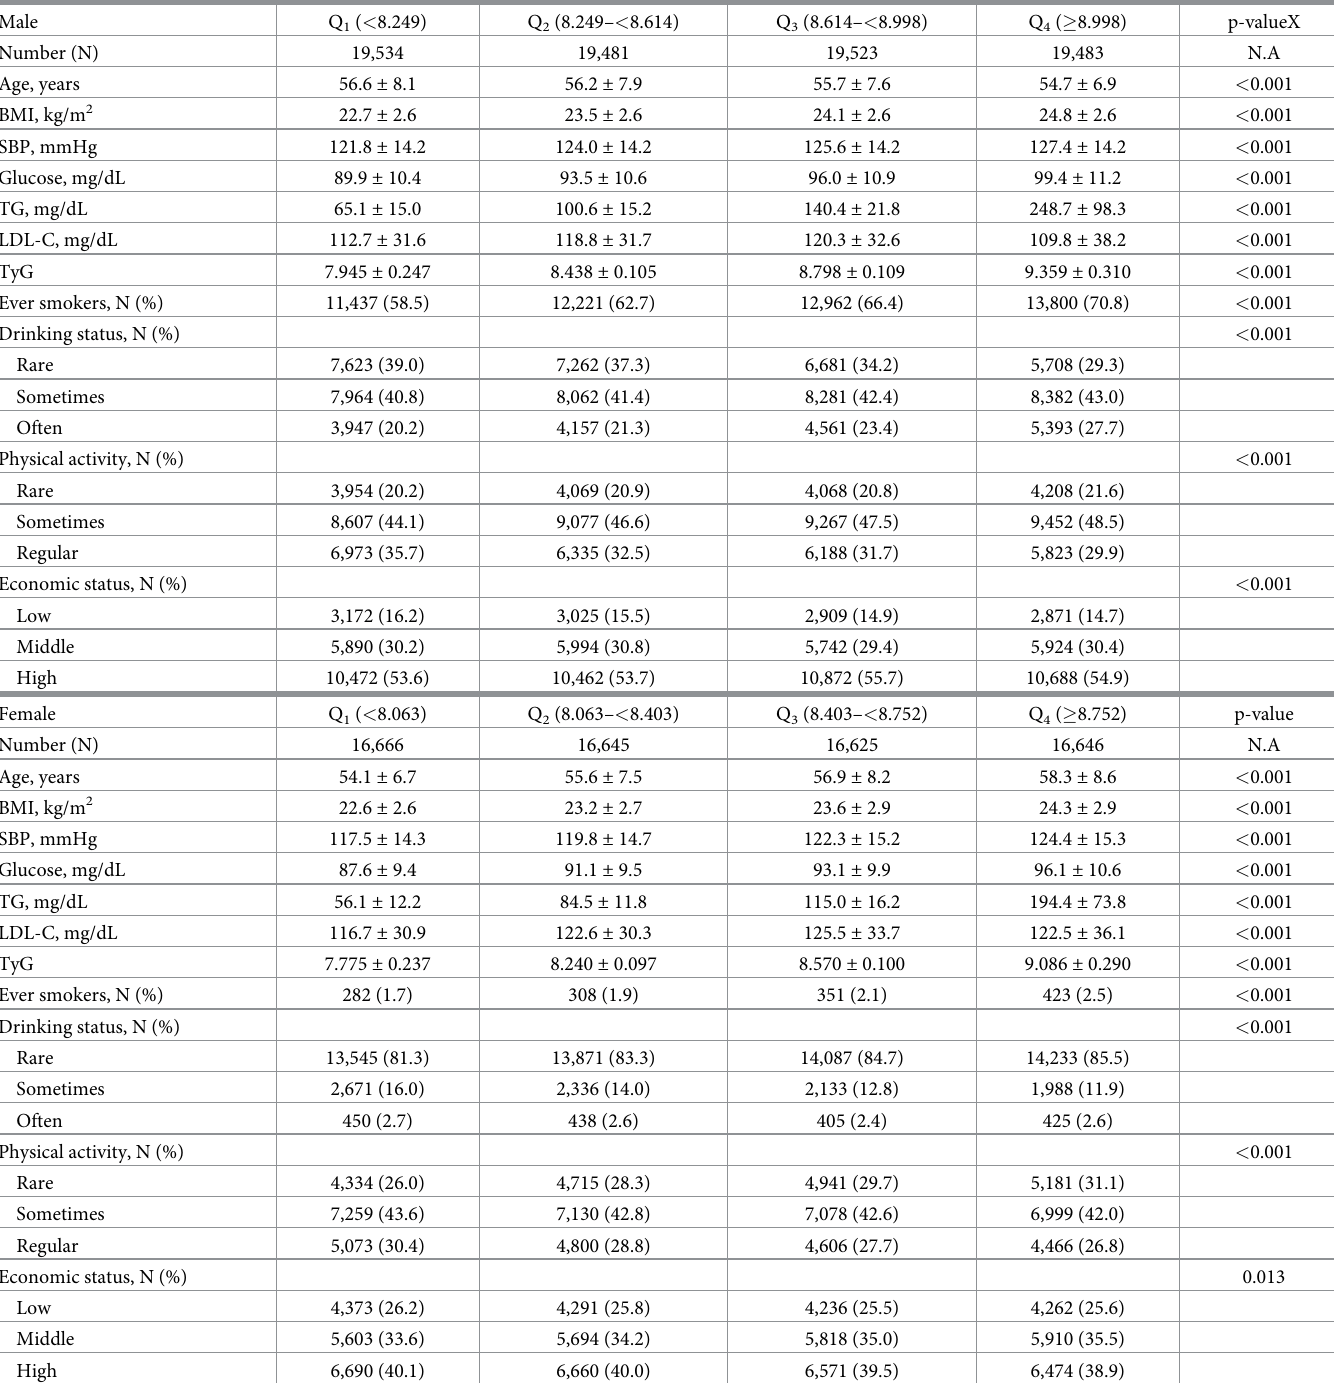
Table 1. Baseline characteristics according to the triglyceride-glucose index